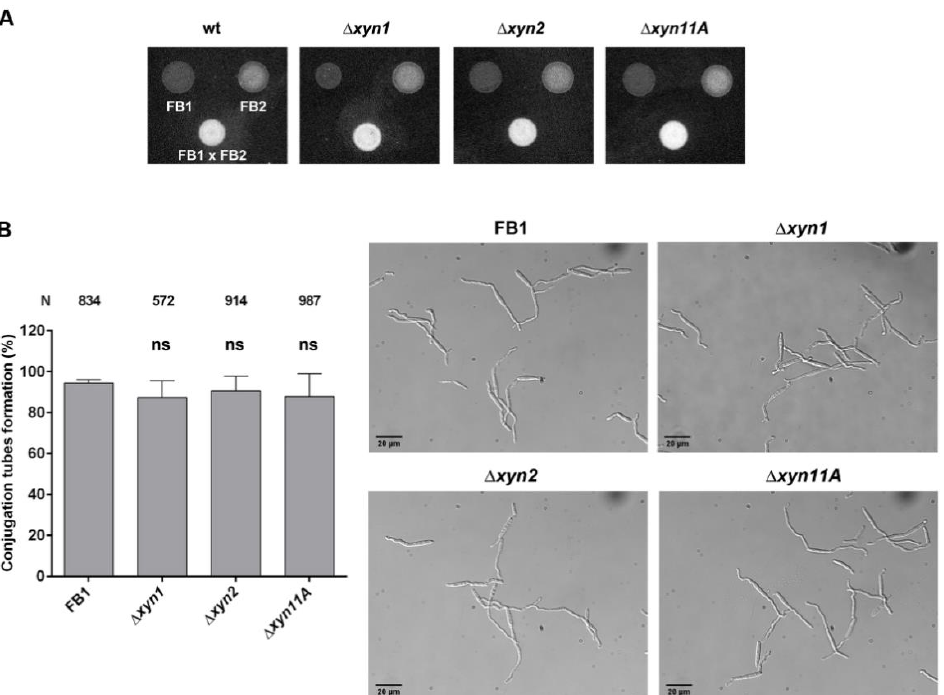
Figure 4. Mating and conjugation tube formation are unaffected by xylanase gene deletion. ( A ) Mating assay between compatible U. maydis FB1 and FB2 wild-type and ∆ xyn1 , ∆ xyn2 , and ∆ xyn11A strains on PD-charcoal (PD-Ch) plates. ( B ) Conjugation tube formation for FB1 wild-type and xylanase deletion mutants was quantified after 5 h incubation with a2 pheromone in axenic conditions. Scale bar represents 20 µ m. Total number of cells, corresponding to four biological replicates, is indicated above each column. T-test statistical analysis was performed (ns, not statistically signifi- cant).